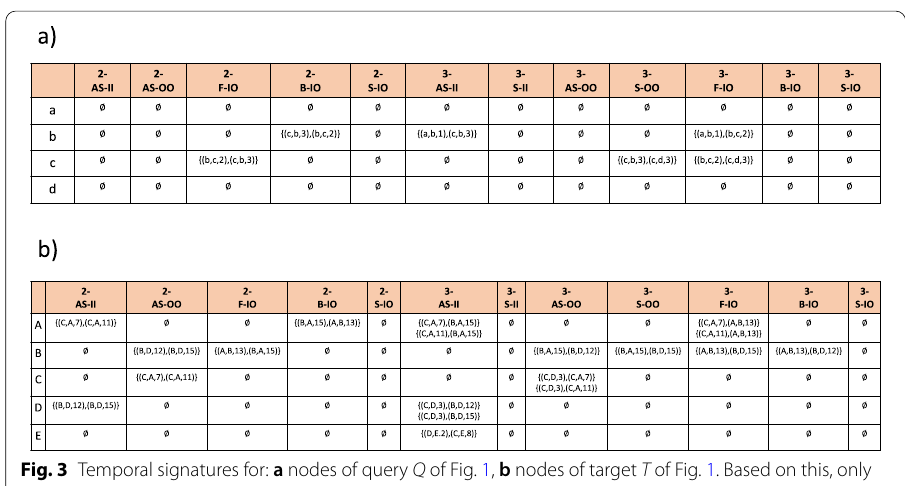
Fig. 3 Temporal signatures for: a nodes of query Q of Fig. 1, b nodes of target T of Fig. 1. Based on this, only target node A temporally includes query node b , because A contains, for each flow type C , at least the same number of flows of type C centered in